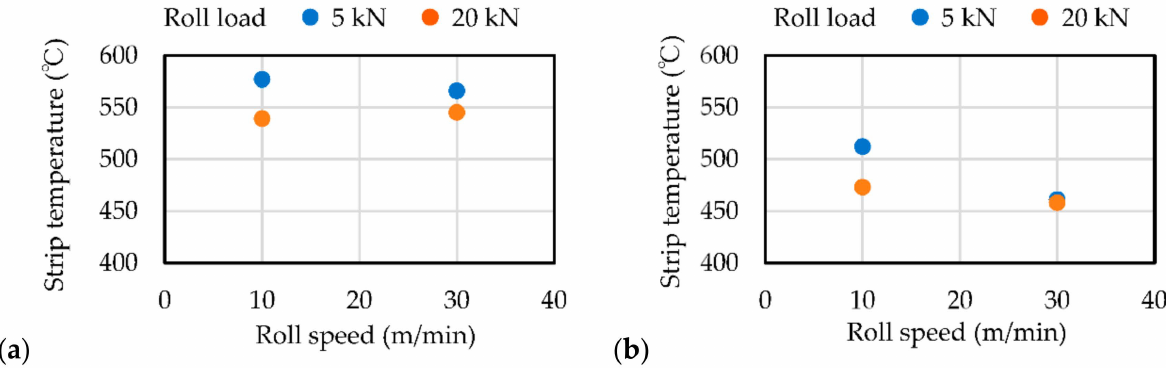
Figure 5. Effects of roll materials on strip temperature at roll bite. The rolling speed was 10 or 30 m/min, and the roll load was 5 or 20 kN. ( a ) Mild steel roll and ( b ) copper